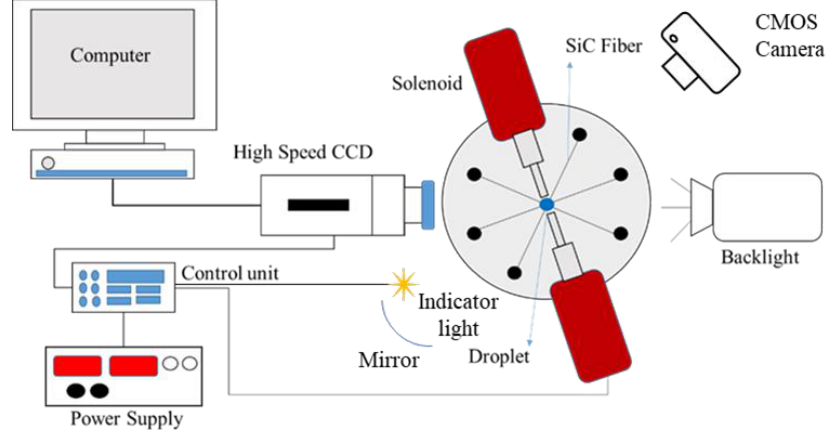
Figure 1. Schematic of experimental setup for crude oil combustion.